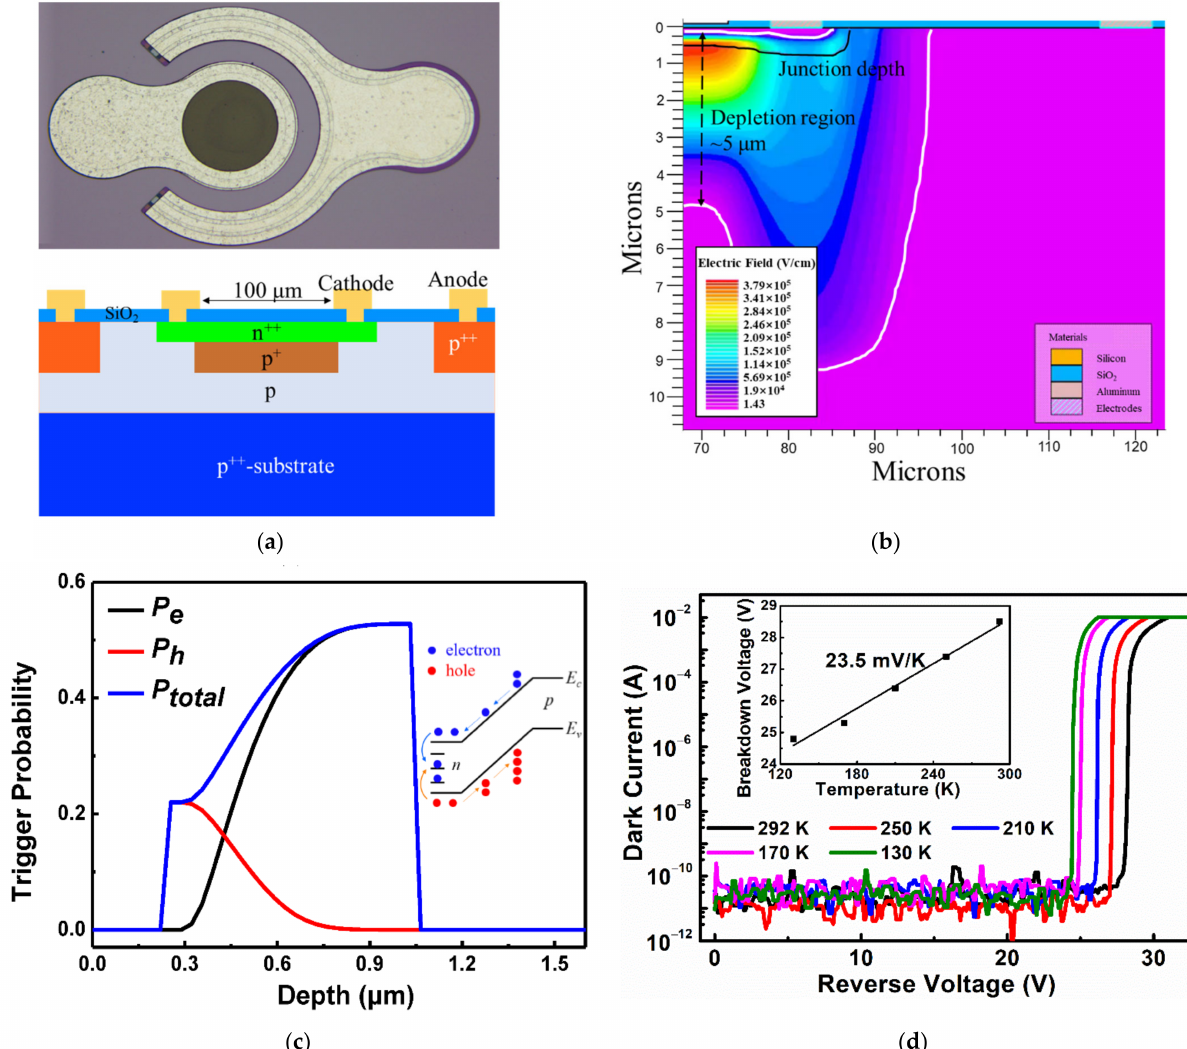
Figure 1. Design and electrical characteristics of the APD. ( a ) Upper panel: an optical microscope of the 100- µ m Si APD. Bottom panel: the cross-sectional view of the device. ( b ) Simulated electric field at breakdown with a depletion region width of ~5 µ m. ( c ) Probability to breakdown is simulated at the V ex of 2.5 V by Sentaurus TCAD. Inset: Illustration of photogenerated carrier transit process under the external bias. Part of photogenerated holes trigger the avalanche, while most of photogenerated electrons are trapped at the Si/SiO 2 interface. ( d ) Measured reverse dark current-voltage (I-V) curves at temperature from 130 K to 292 K in steps of about 40 K, respectively, for a Si APD with a diameter of 100 µ m. Inset: Temperature dependence of V br , which is calculated to be 23.5 mV/K for the temperature ranging from 130 K to 292